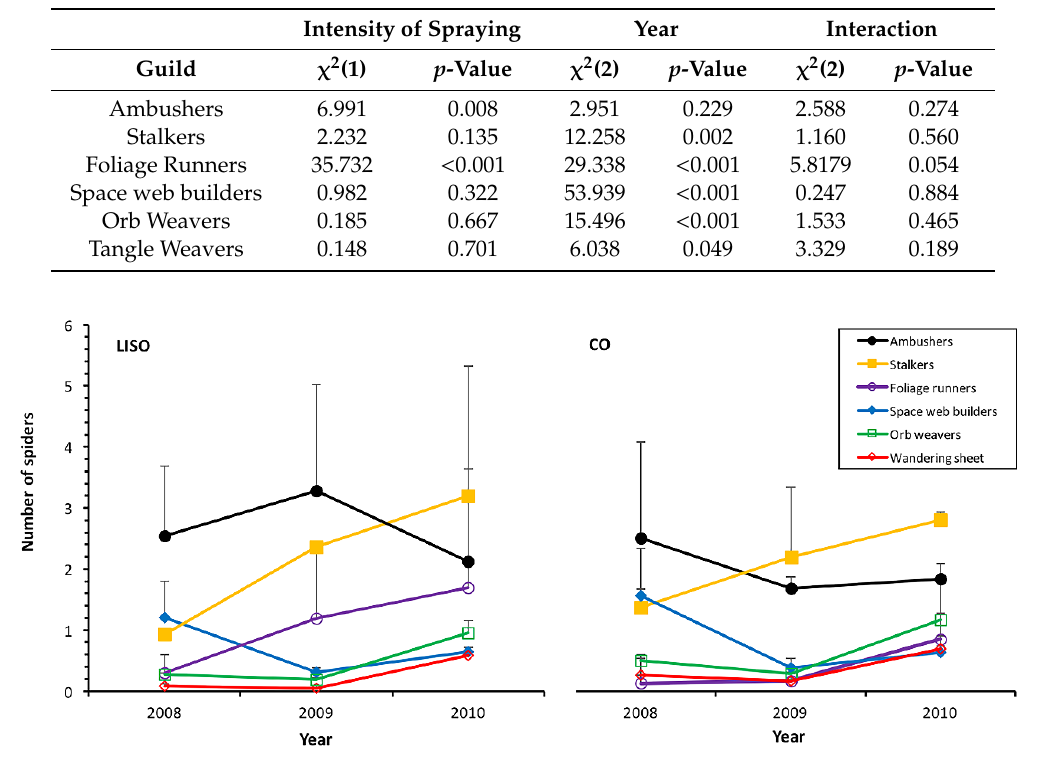
Table 3. Statistics of generalized linear mixed models (GLMM) for the effect of intensity of spraying, year, and their interaction on the abundance of the main spider guilds. χ 2 = Chi square values (degrees of freedom within brackets).